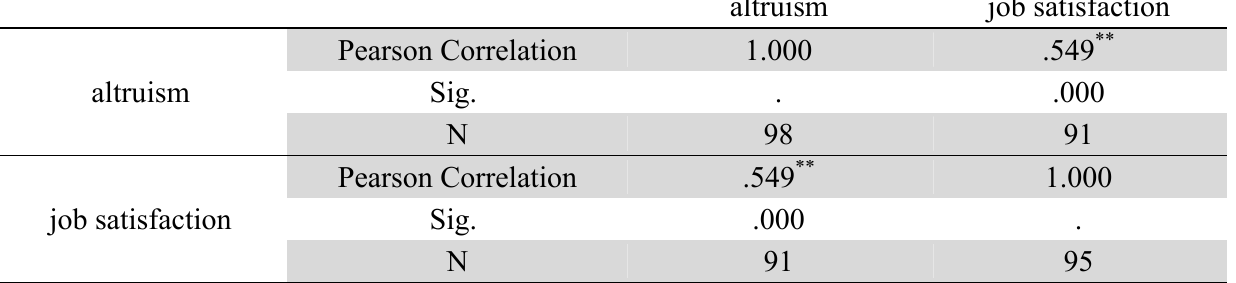
The relationship between altruism and job